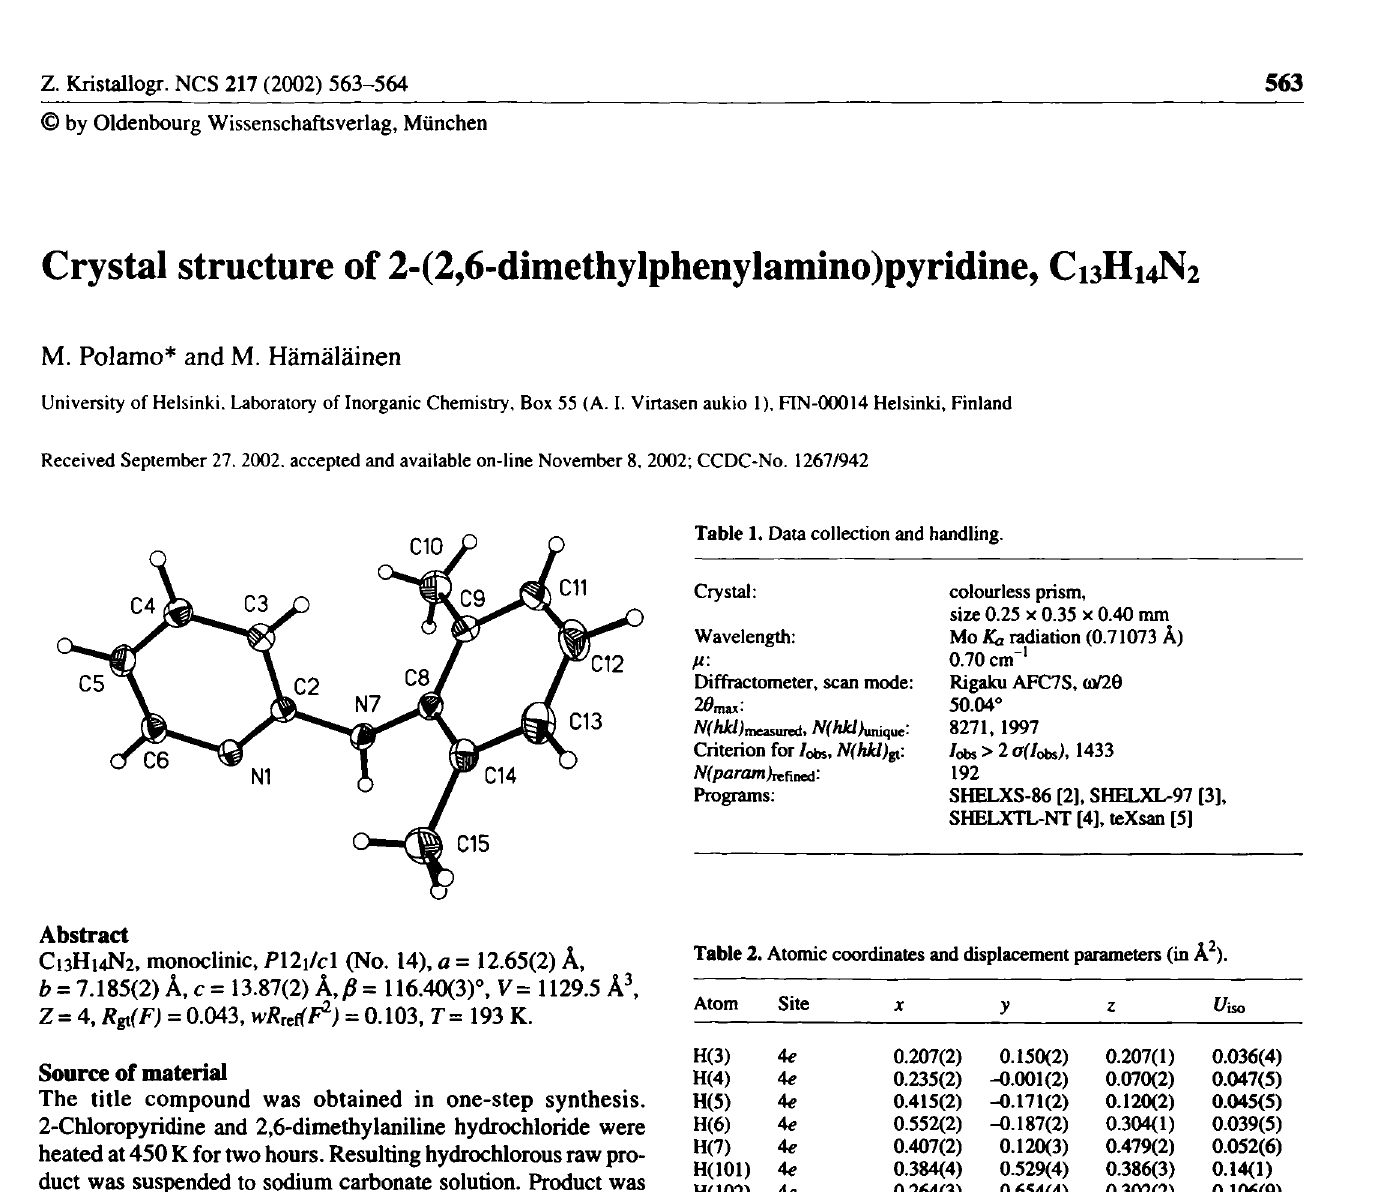
Table 2. Atomic coordinates and displacement parameters (in Â 2